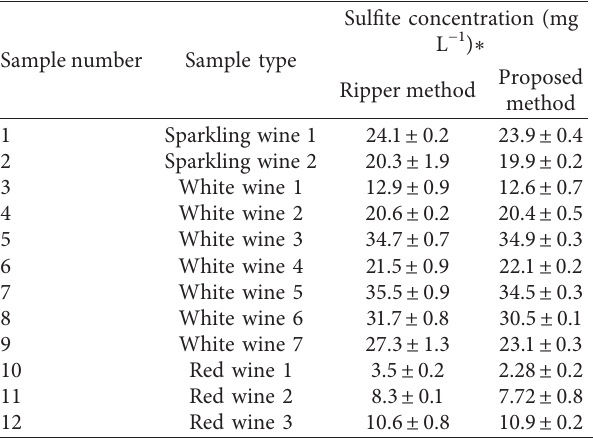
Figure 5: Recorder output of a routine run. Number of replicates: 3; left: standard solutions, right: sample; inset: plot of the analytical curve. Table 3: Sulfite contents in wines as determined by the proposed method and the Ripper